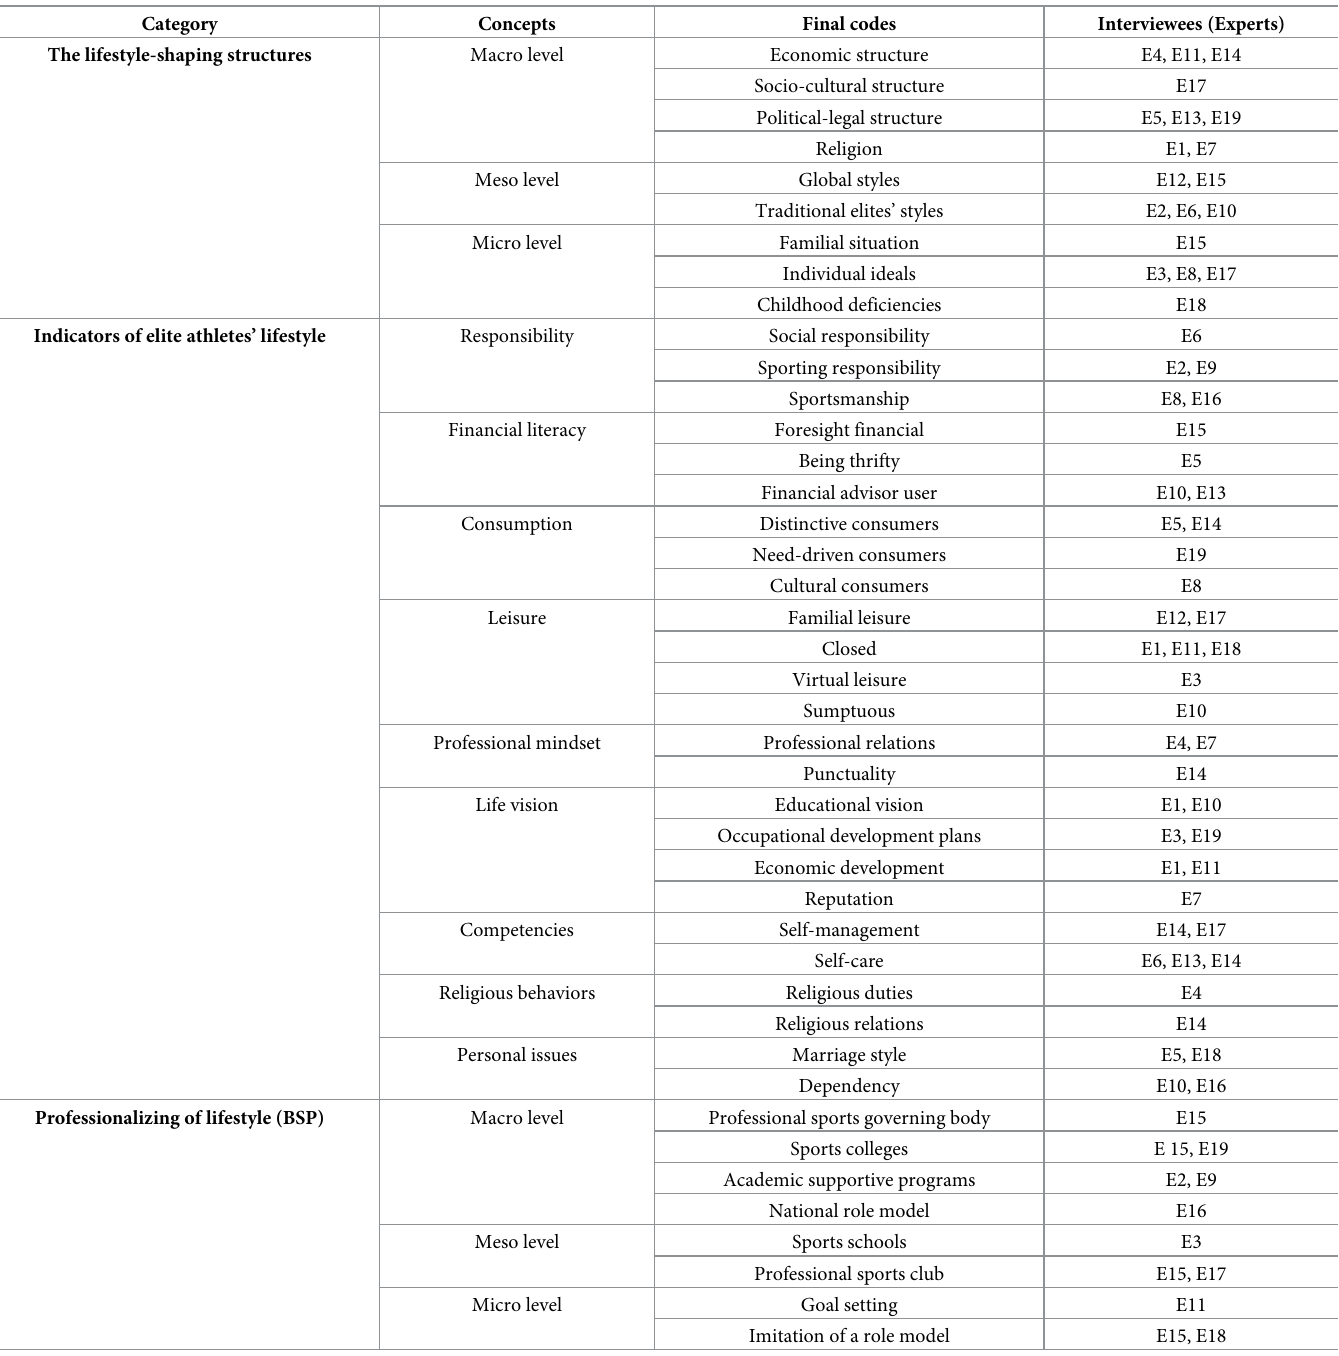
Table 3. Categories, concepts, and emerged codes by participants